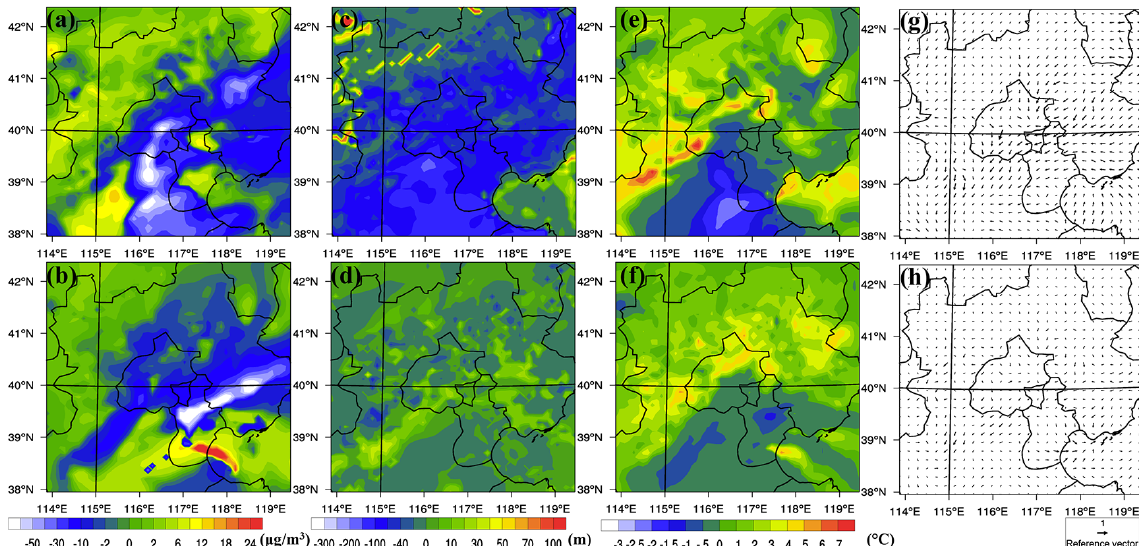
Figure 16. Differences of PM 2 . 5 concentration (unit: µgm − 3 ) , temperature (unit: ◦ C), PBLH (unit: m) and horizontal wind (unit: ms − 1 ) at 02:00p.m. (a, c, e, g) and 02:00a.m. (b, d, f, h) between WF and NBCA